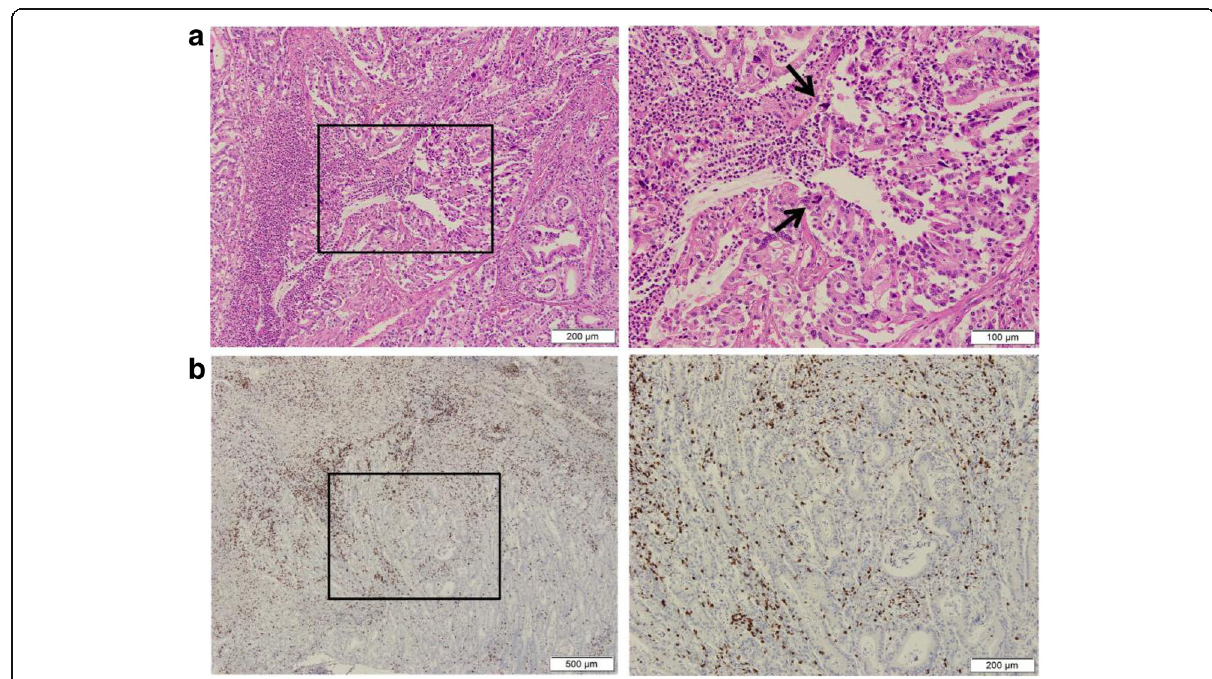
Fig. 6 Representative hematoxylin – eosin-stained images and CD3+ immunohistochemistry results in the resected specimen. a Tumor with irregular pyknotic nuclei (arrows) and tumor-infiltrating lymphocytes. Original magnification ×200 (right) and corresponding (boxed) areas with lower magnification ×100 (left). b Rich lymphocytic infiltration into the tumor. CD3 + T cells are indicated by the brown chromogen. Original magnification ×100 (right) and corresponding (boxed) areas with lower magnification ×40